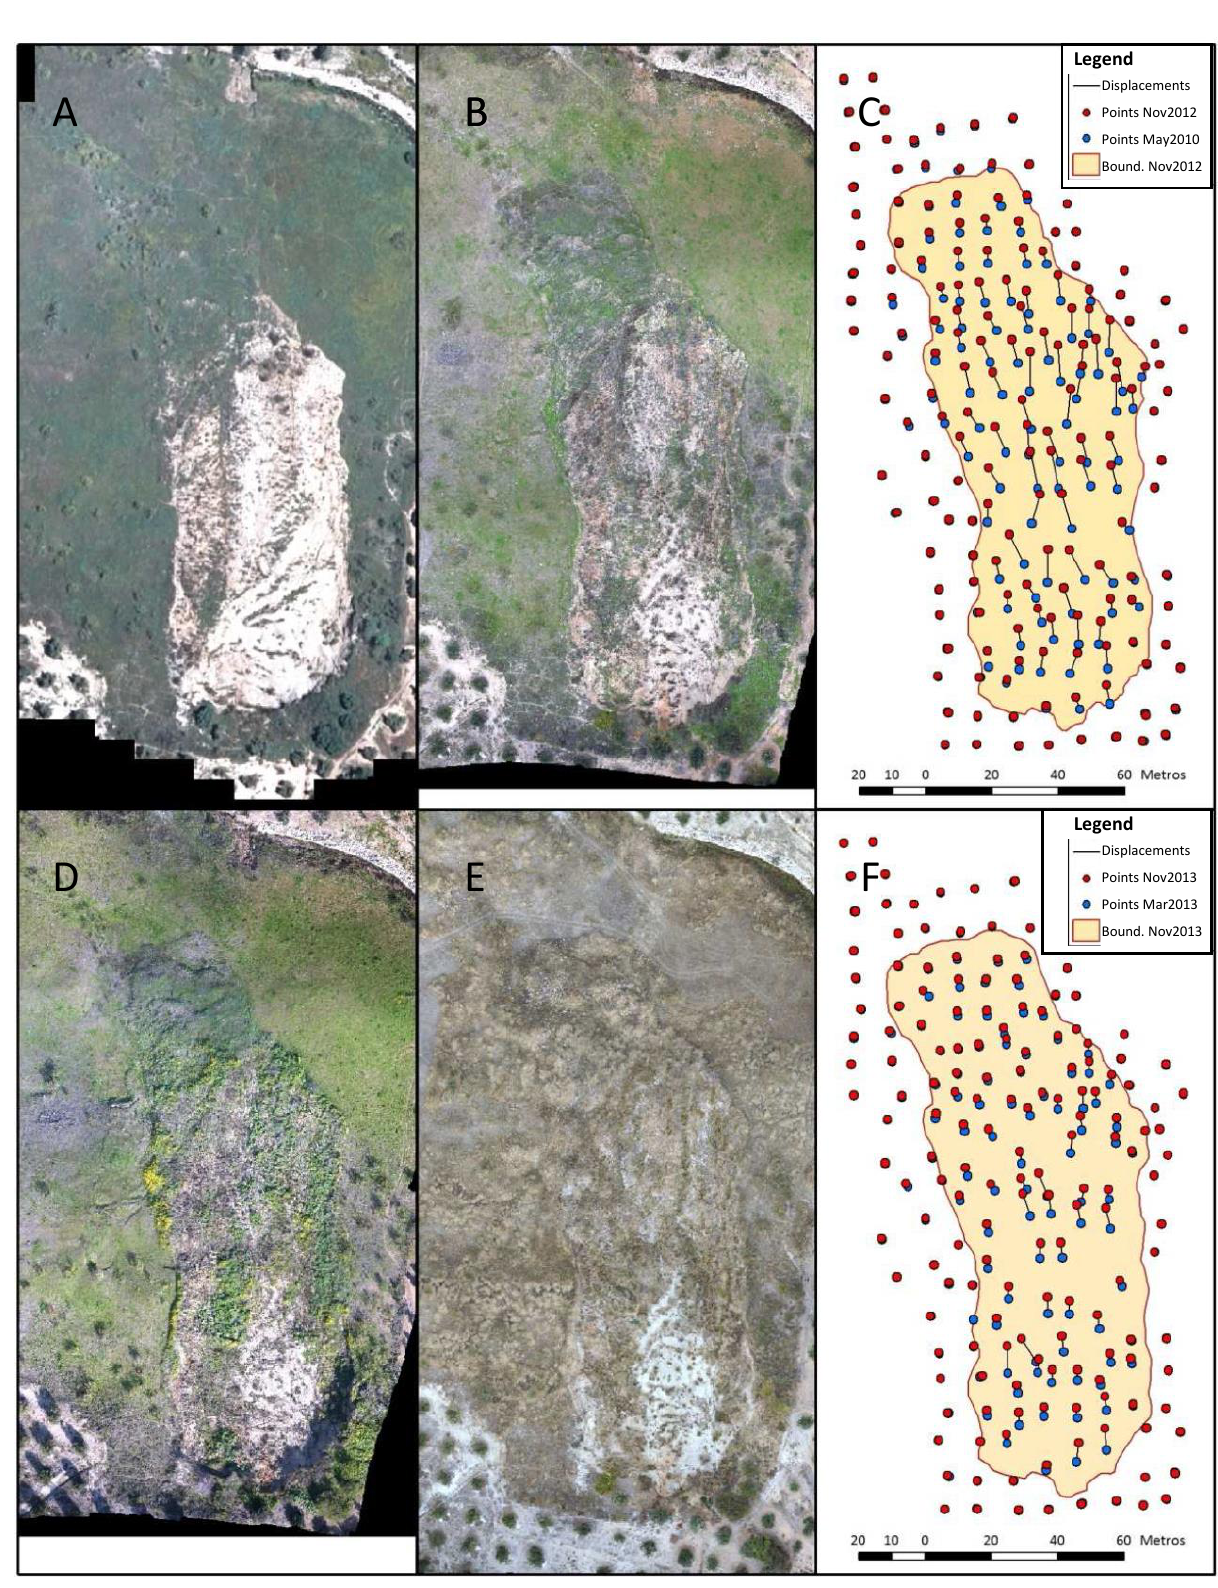
Figure 7. Orthophotos and horizontal displacements. A: Flight on May 2010; B: Flight on November 2012; C: Displacement vectors between flights on May 2010 and November 2012; D: Flight on March 2013; E: Flight on November 2013; F: Displacement vectors between flights on March 2013 and November